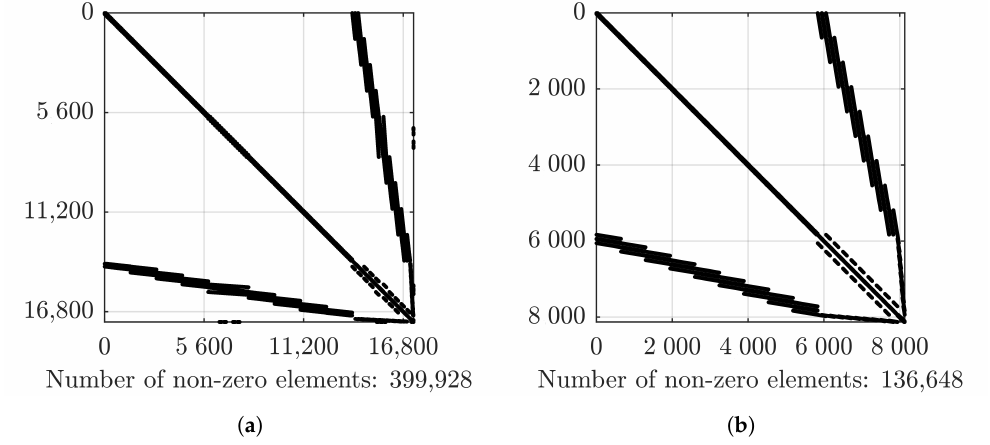
Figure 8. Sparsity patterns of the global matrices in the ( a ) electromagnetic and ( b ) thermal SEM model of the benchmark